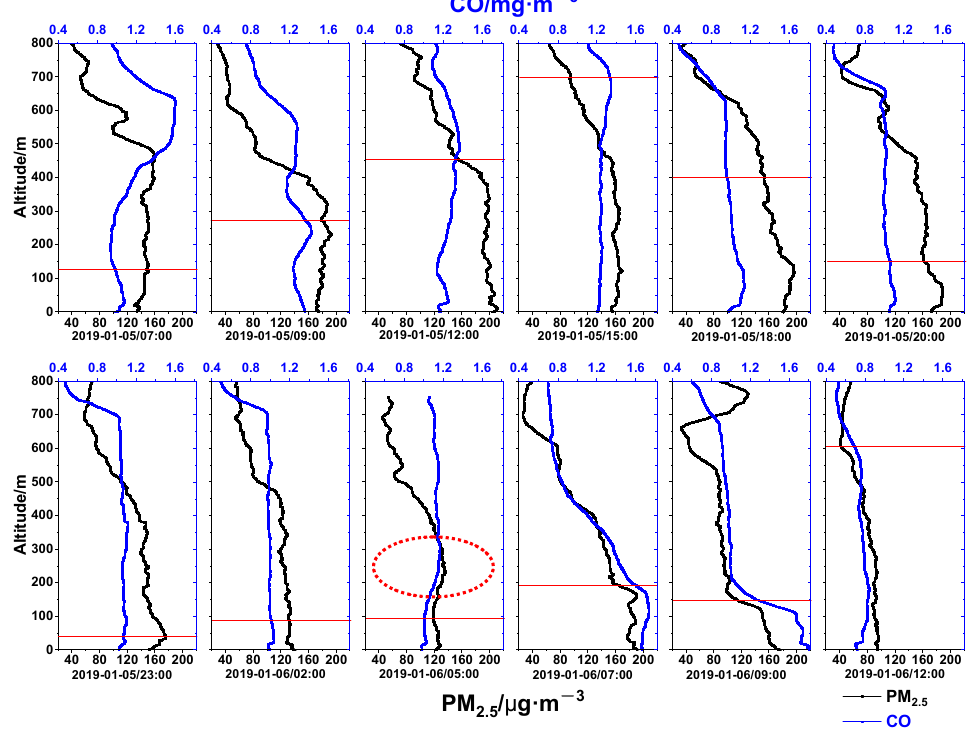
Figure 6. The profiles of the PM 2.5 and CO concentrations detected by the UAV and the boundary layer height (red solid line) from 07:00 LST on 5 January to 12:00 LST on 6 January, 2019. The red circle denotes the period of pollutants maintaining high concentration in the upper RL.